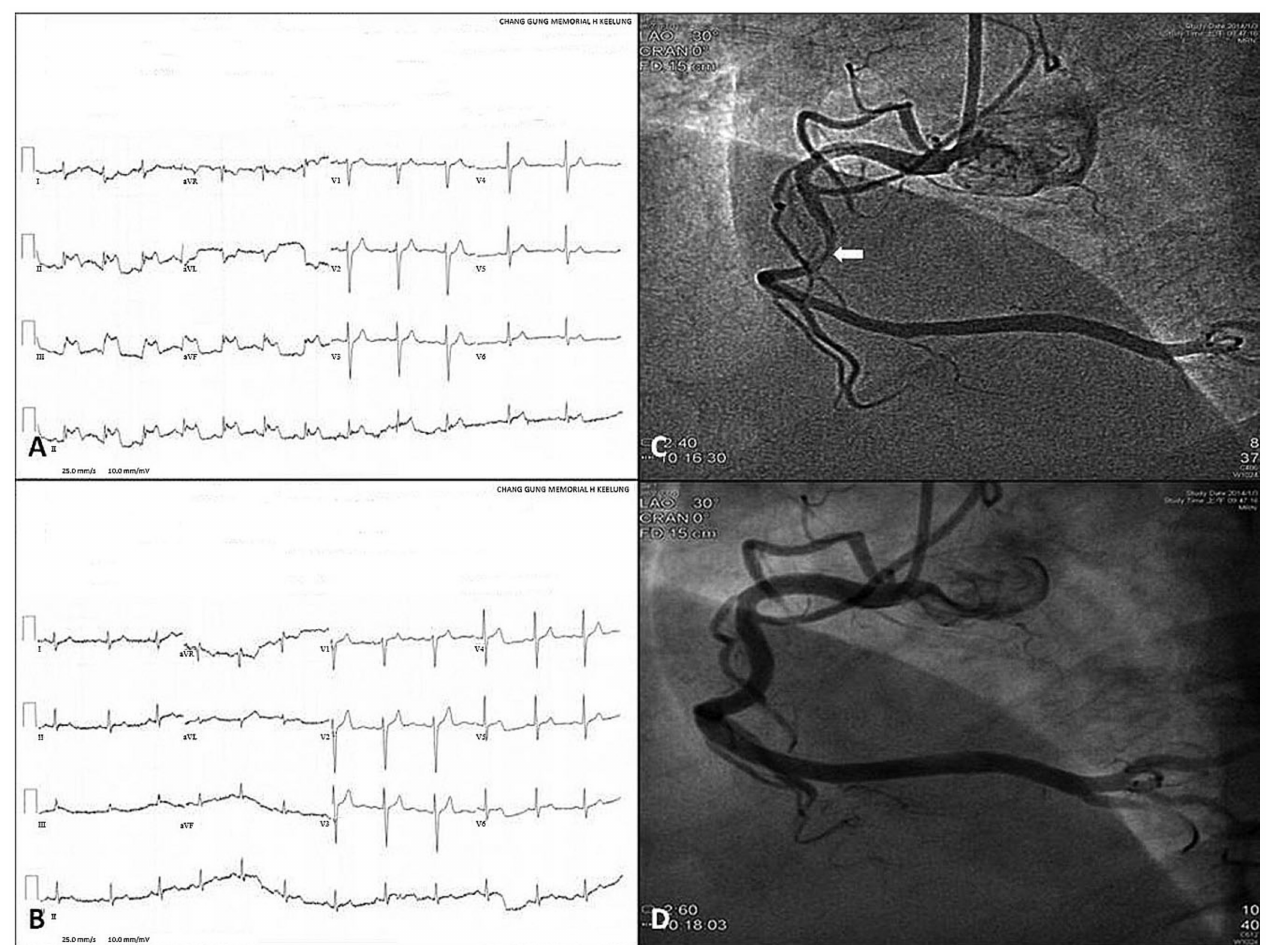
Figure 1. The 12-lead electrocardiograms and coronary angiography of variant angina. Angina attack ( A ) and post-sublingual nitroglycerin 0.6 mg ( B ) 12-lead electrocardiograms of a 47-year-old male revealed brief ST-segment elevation in II, III, and aVF leads. Ten months later because of recurrent chest pain, he underwent coronary angiography. The coronary angiography revealed intracoronary methylergonovine-induced CAS in the middle portion of the right coronary artery ( C , arrow), which was alleviated after intracoronary nitroglycerin 200 µ g ( D ). (Reproduced from [33], with permission of the